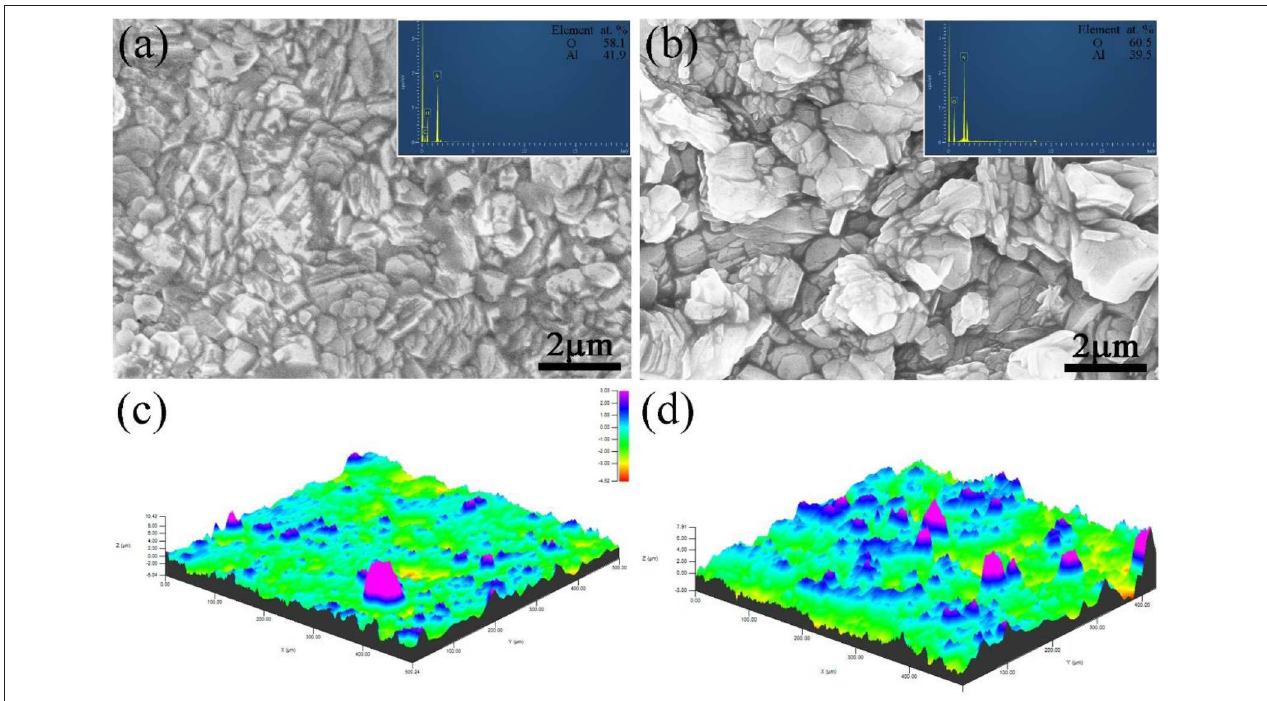
FIGURE 11 | Surface roughness of the surface for the coated samples S1 and S4 before and after oxidation.